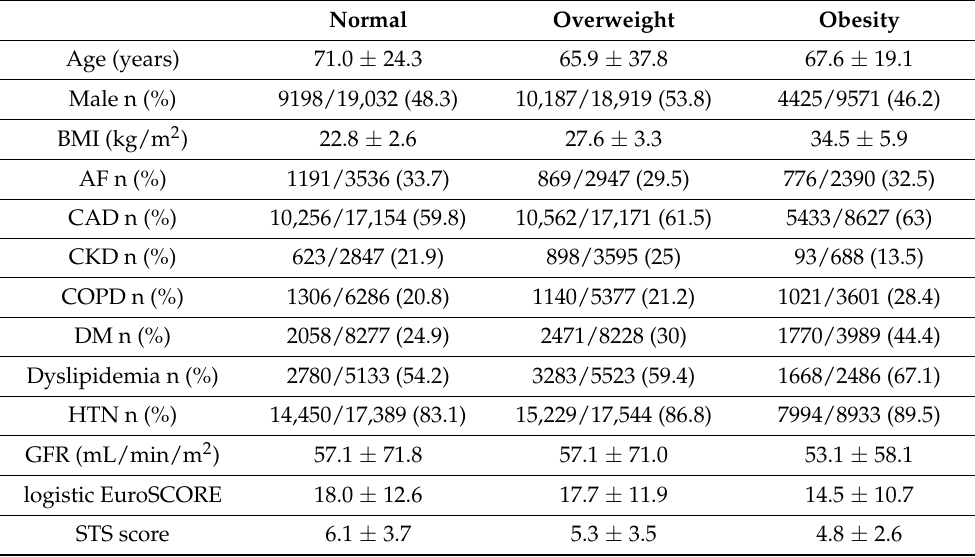
Table 2. Basic characteristics of normal, overweight, and obesity BMI patients.